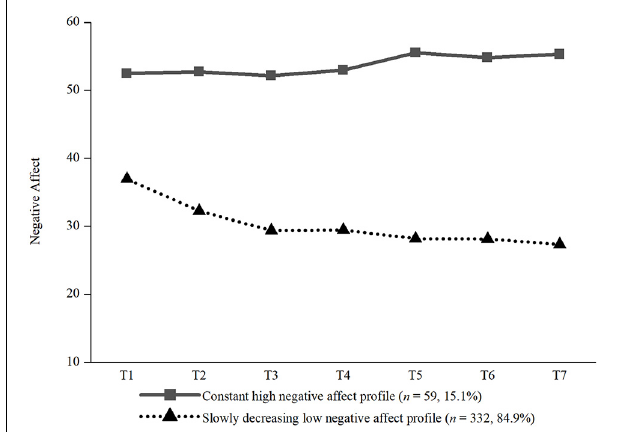
FIGURE 1 | The two trajectories of negative affect. N = 391, T1 = Monday, T2 = Tuesday, T3 = Wednesday, T4 = Thursday, T5 = Friday, T6 = Saturday, T7 =